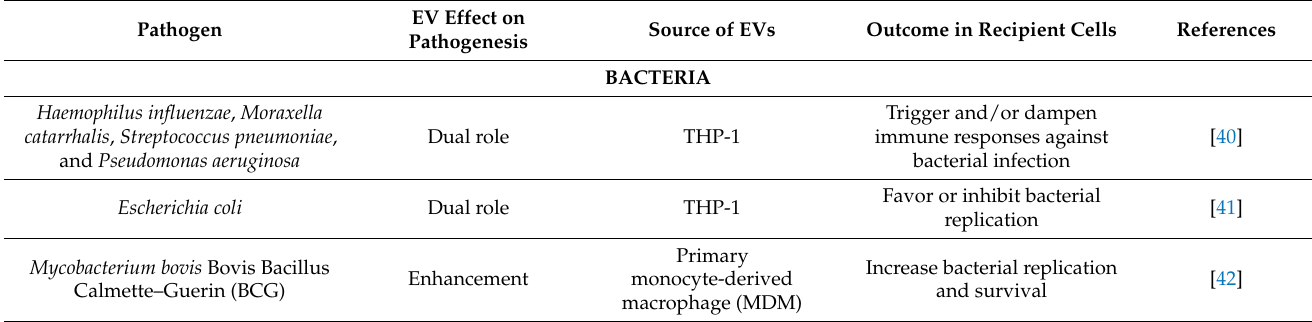
Table 1. Available studies * of EVs released by human macrophages during infectious diseases.